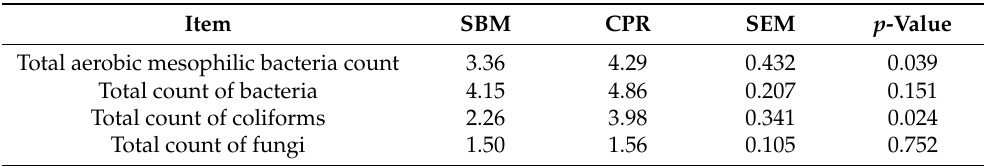
Table 6. Concentration (log cfu/g) of microorganisms in the intestinal contents of 42-day-old broiler chickens 1 .